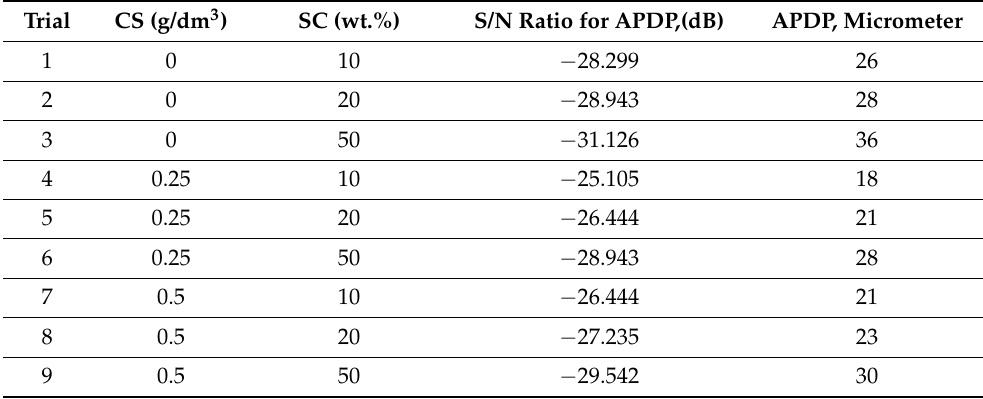
Table 2. S/N S ratios of SB for